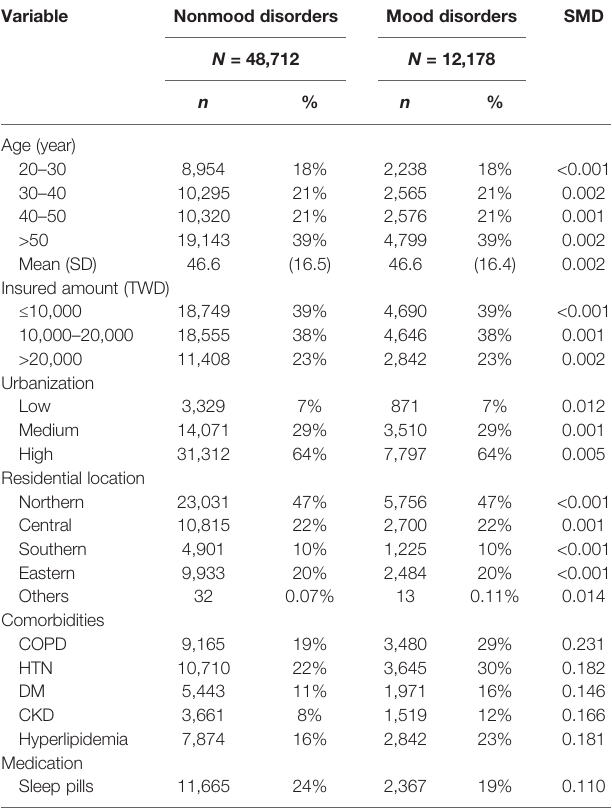
TABLE 3 | The baseline characteristics of patients with and without mood disorders.